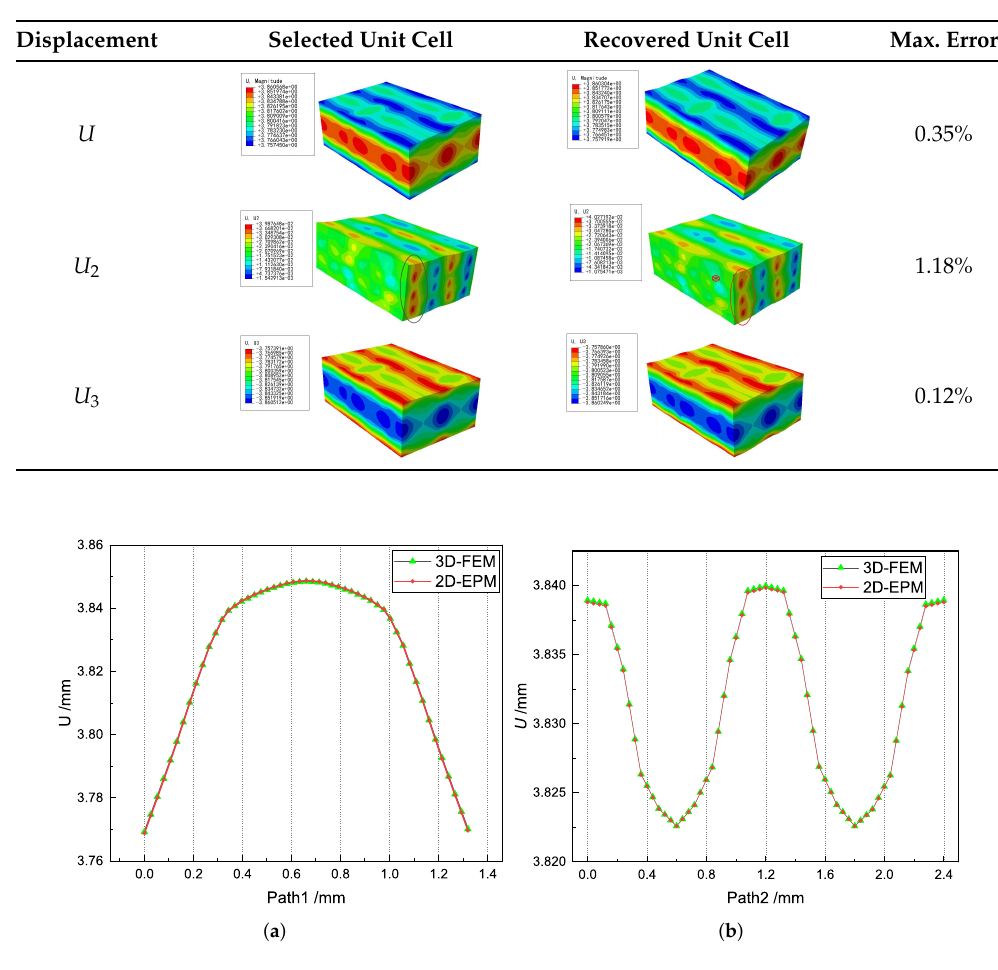
Figure 9. Comparison of local displacement curves along Path 1 and Path 2 of the unit cell predicted by two models under the conditions in Case 2. ( a ) U along Path 1; ( b ) U along Path 2. Table 6. Comparison of local stress field within the unit cell under the conditions in Case 2 (unit: MPa). Stress Selected Unit